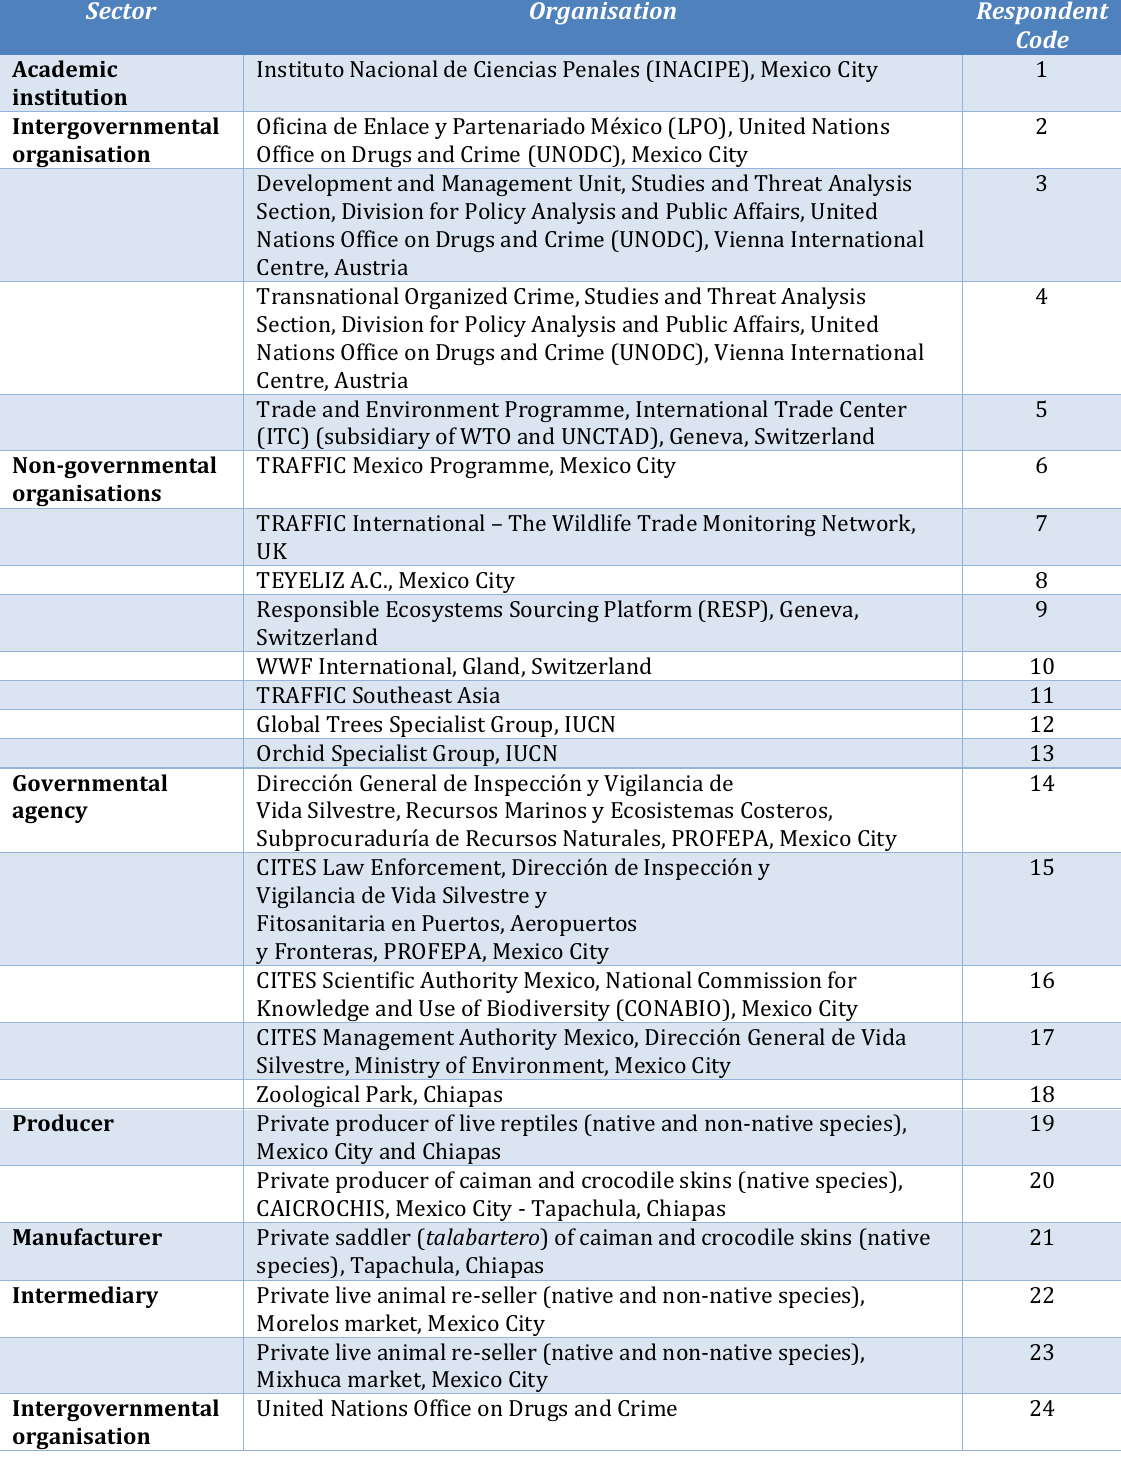
Table 1: Interviews in Mexico, Europe, and relevant regions